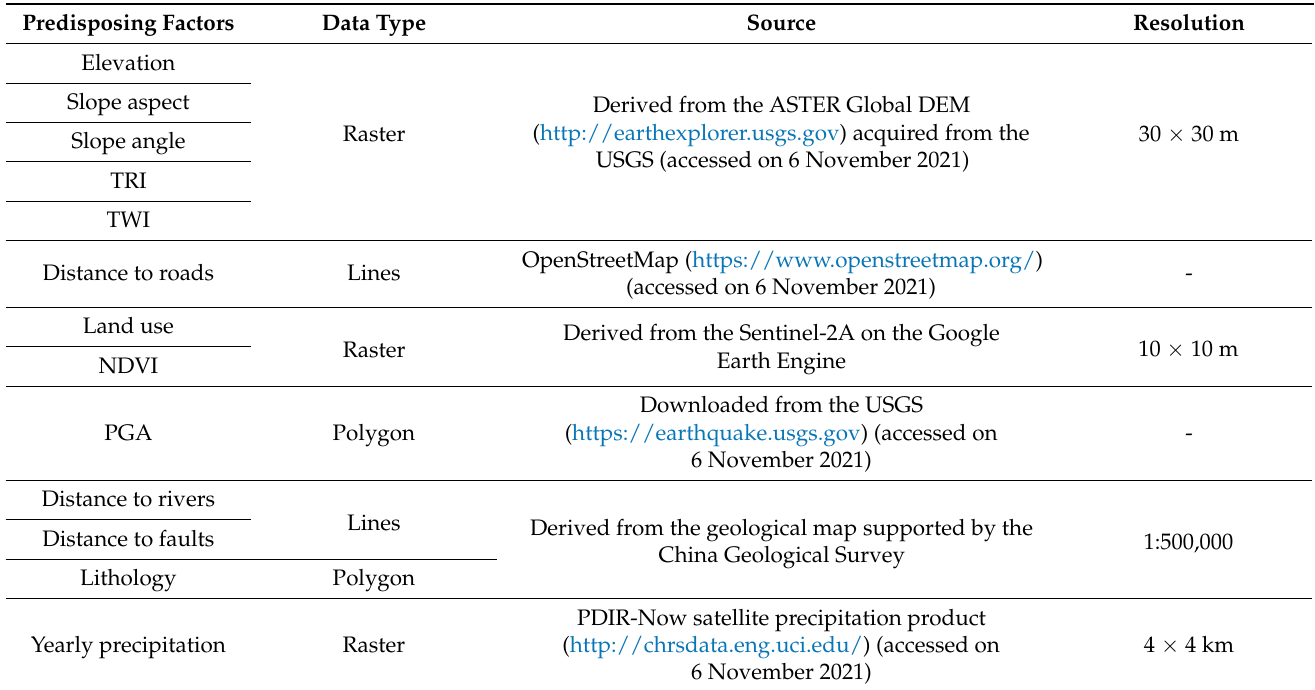
Table 1. Information of predisposing factors for modeling Zhangzha Town’s landslide